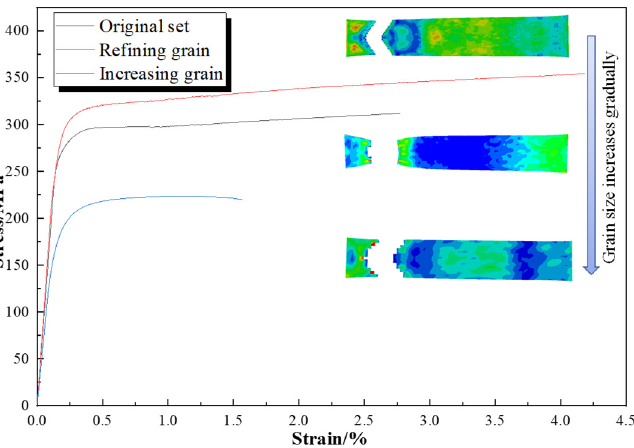
Figure 10. Comparison results under different grain and grain boundary sizes.